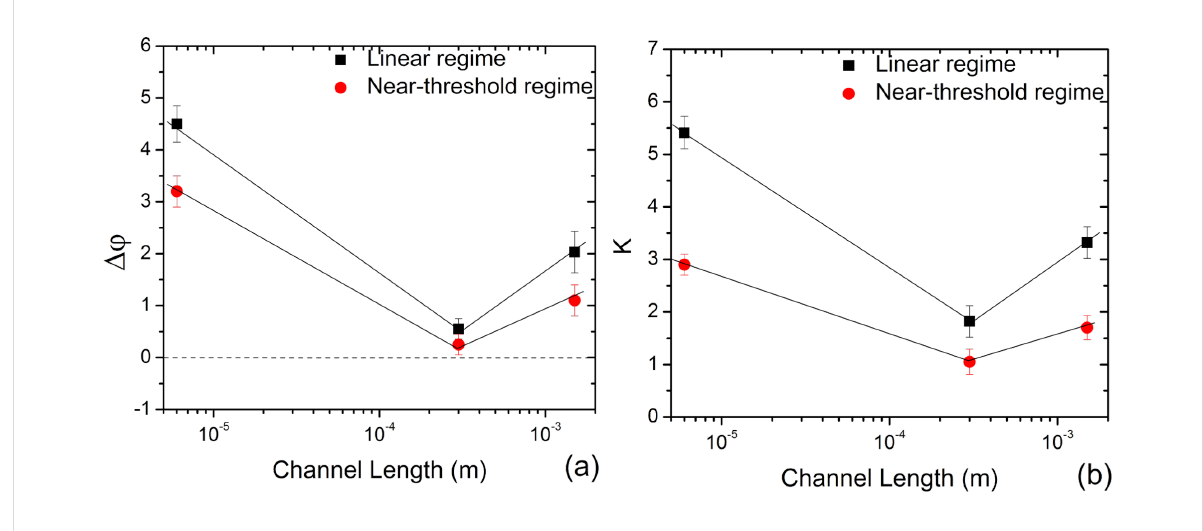
Figure 5: The variation in (a) Δφ and (b) K with L in the linear and near-threshold regimes for the forward sweep. The solid lines are a guide to the eye.